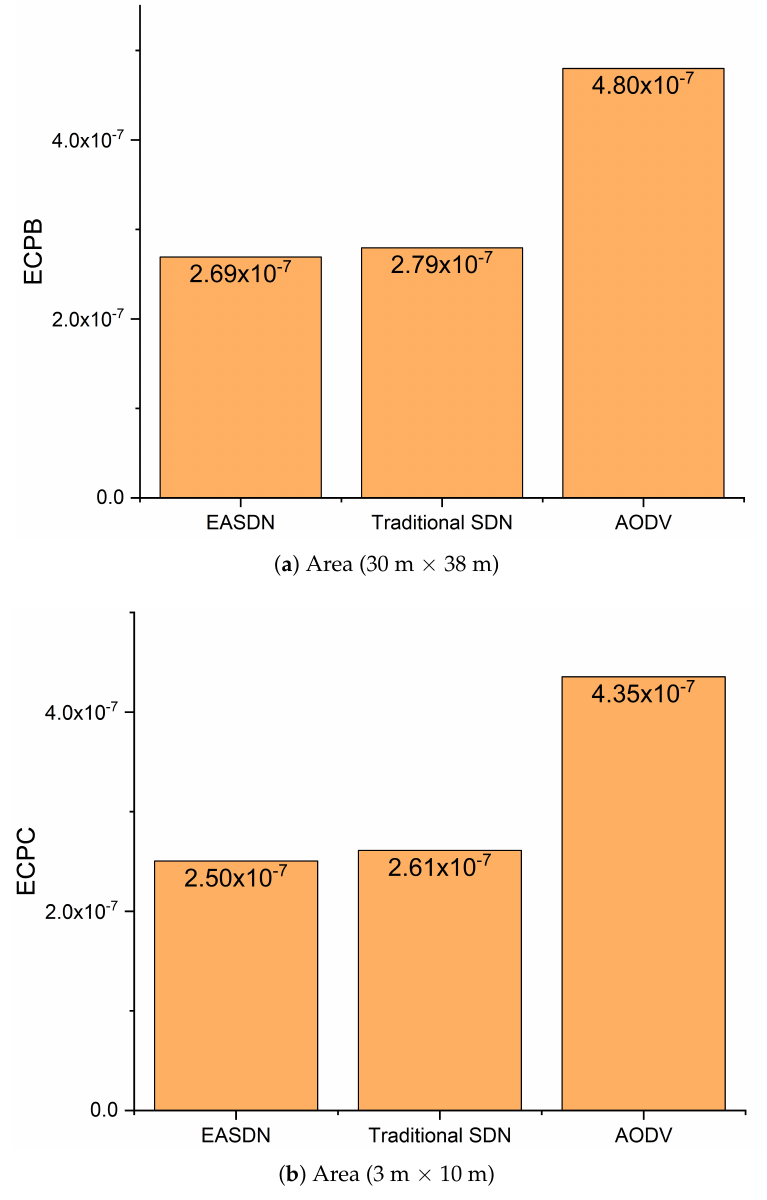
Figure 13. Energy